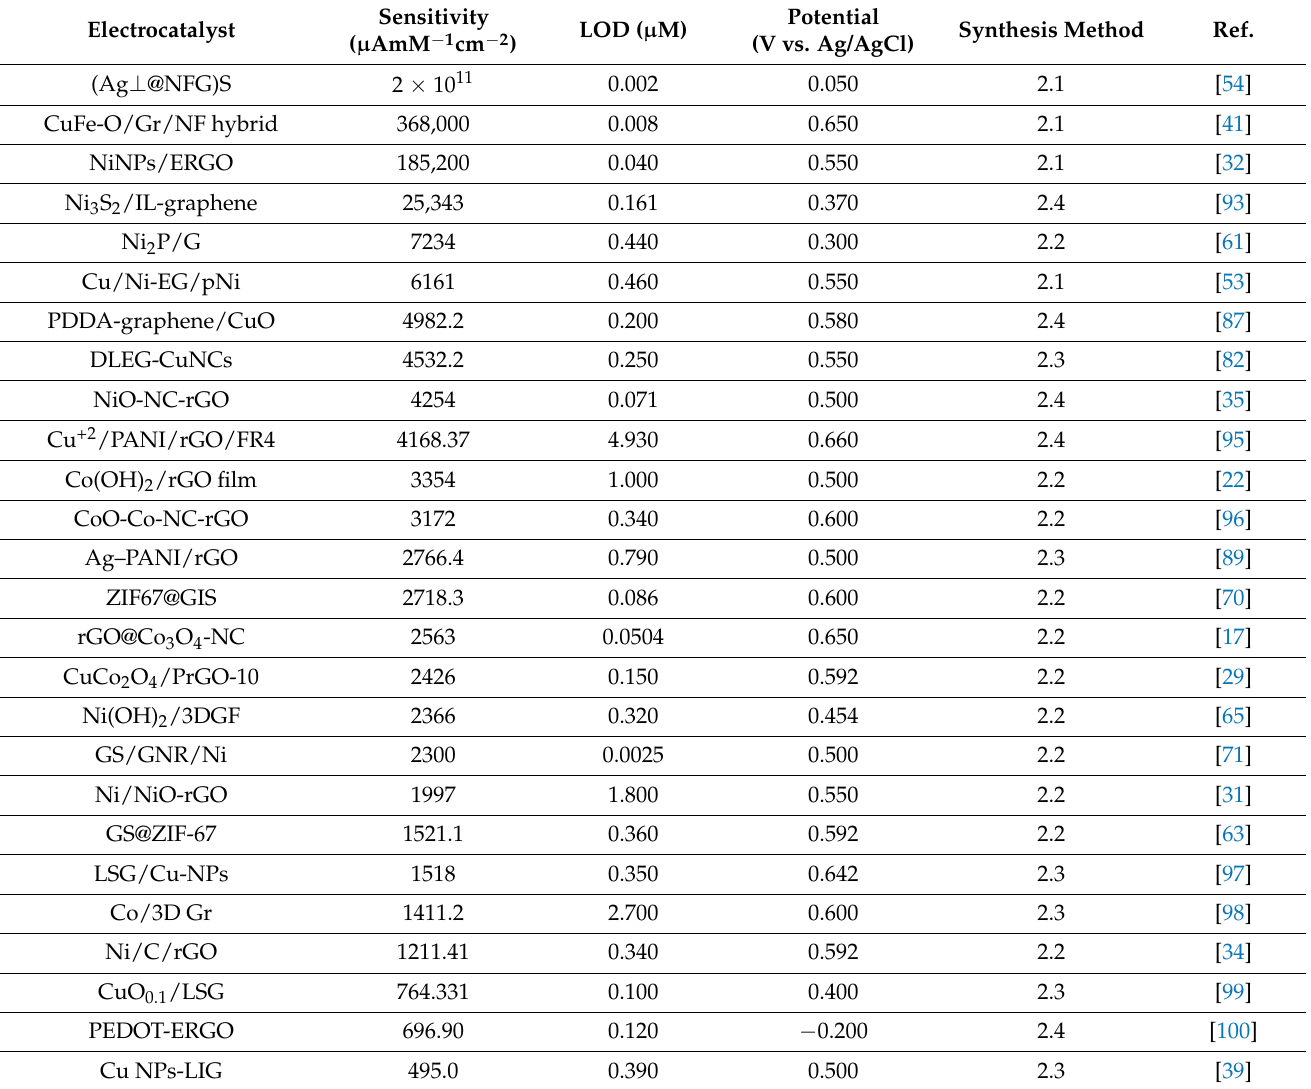
Table 1. Electrocatalysts classification with descending sensitivity and synthesis method according to the current